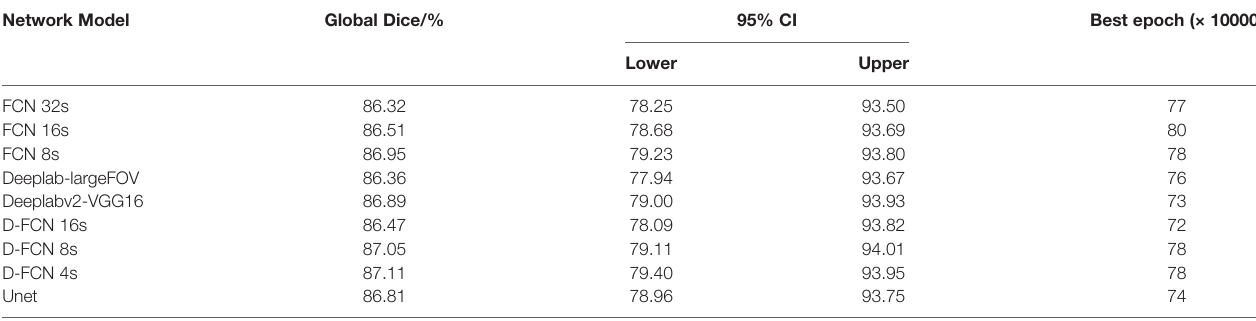
CI, con fi dence interval.